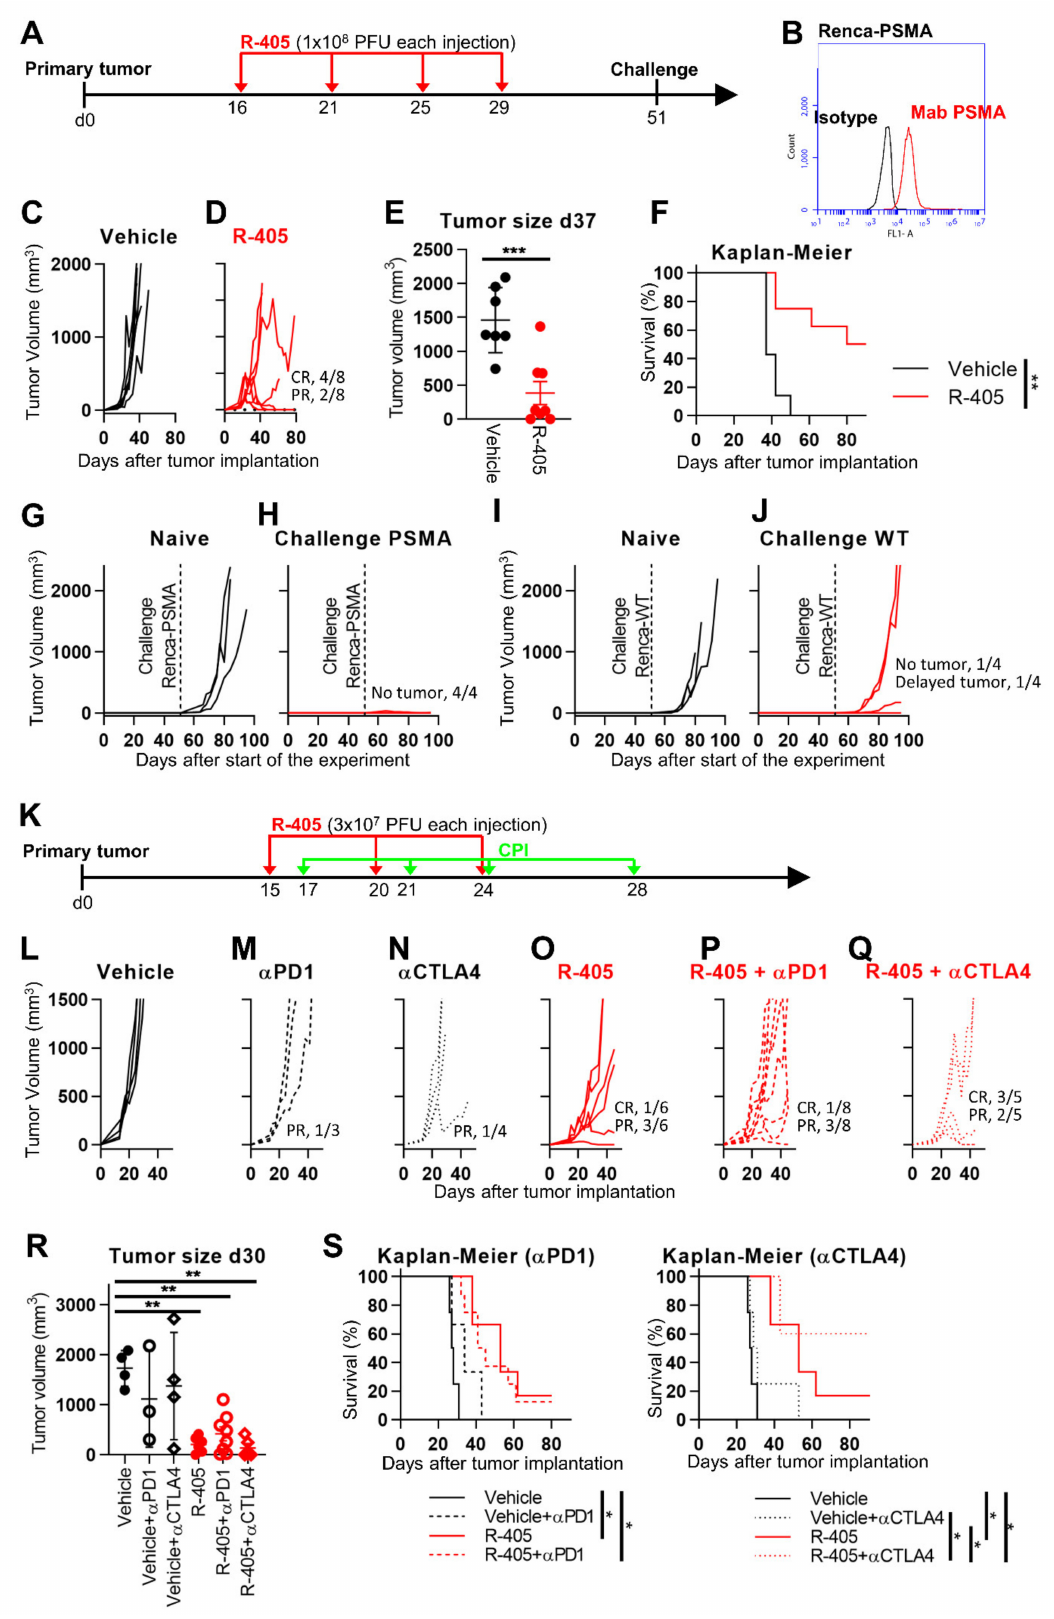
Figure 6. Efficacy of R-405 monotherapy and combination therapies on the growth of Renca-PSMA tumors. ( A ) Schedule of monotherapy treatment. Mice were s.c. implanted in the left flank with 1 × 10 6 Renca-PSMA cells in 100 µ L of PBS. 16 d